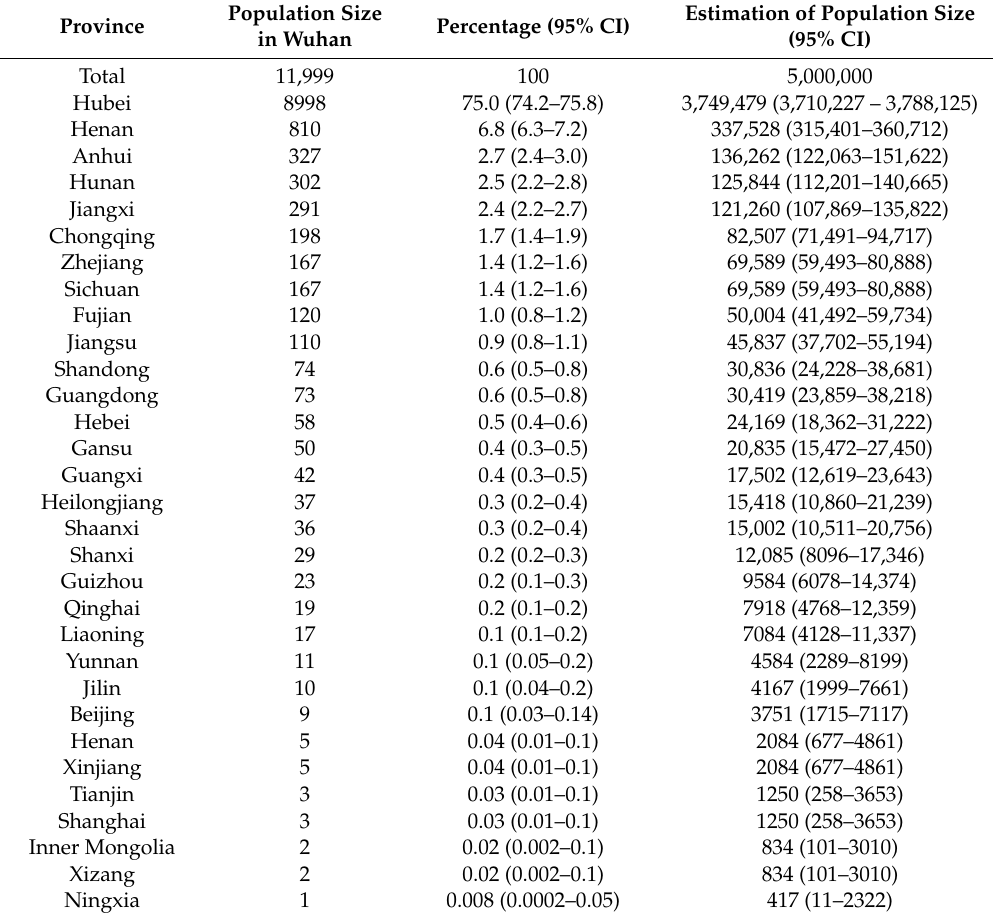
Table 4. Estimation of proportion and population size in China based on floating population in Wuhan,